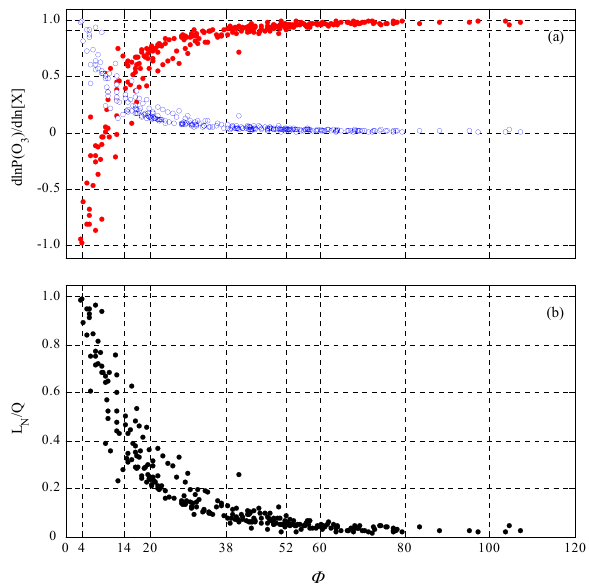
Fig. 5. Dependence of (a) dln P (O 3 )/dln[NO] (shown by red dot) and dln P (O 3 )/dln[HC] (shown by open blue circle) and (b) L N /Q on Φ for daytime 10-min average data during 18-21 September, 2003. The ranges of two borders are also labeled in this figure.